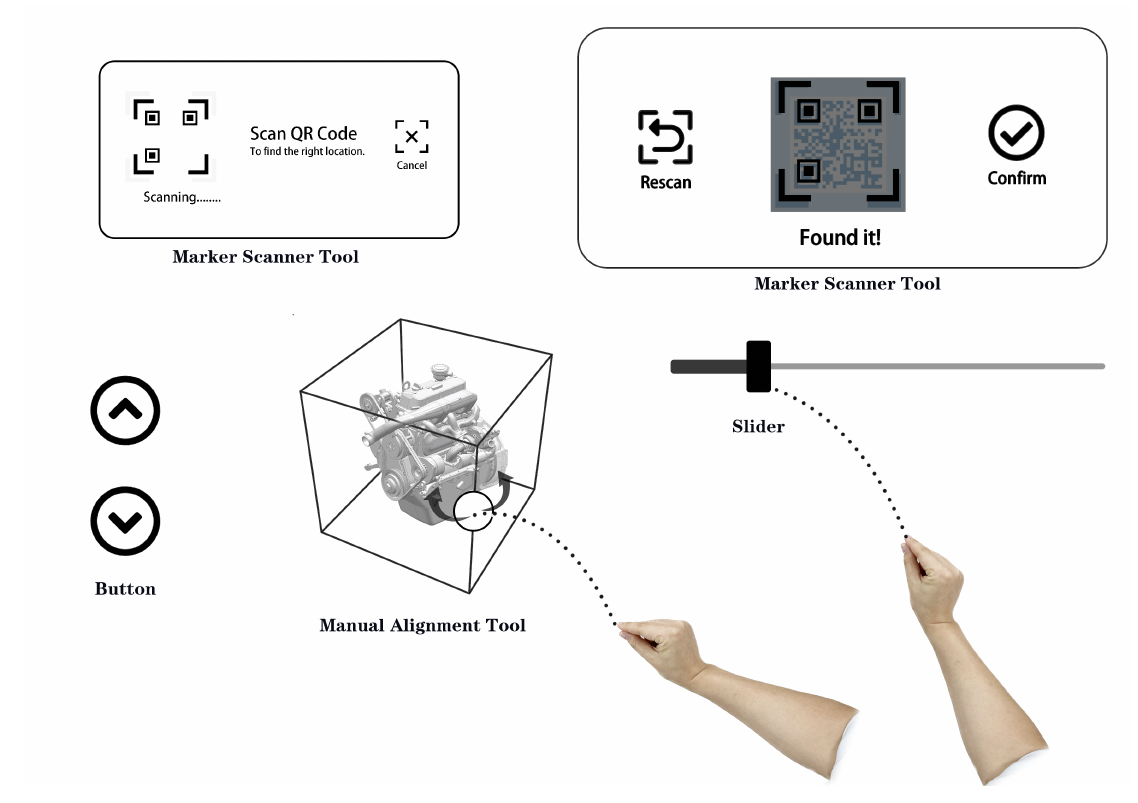
Figure 7. Sketch of Input Controls Components.